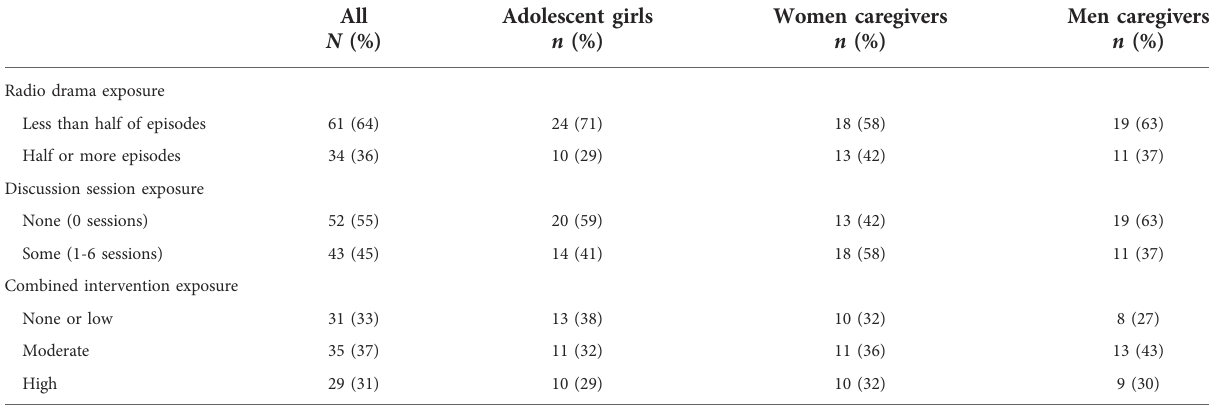
TABLE 5 Quantitative study participant ’ s self-reported exposure to the LINEA radio drama, and implementation data on exposure to household discussion sessions.